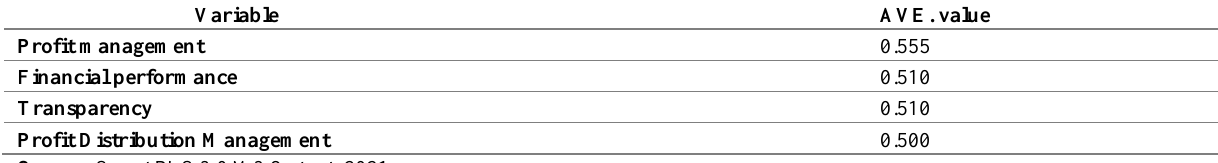
Table 5: Measurement of Average Variance Extracted